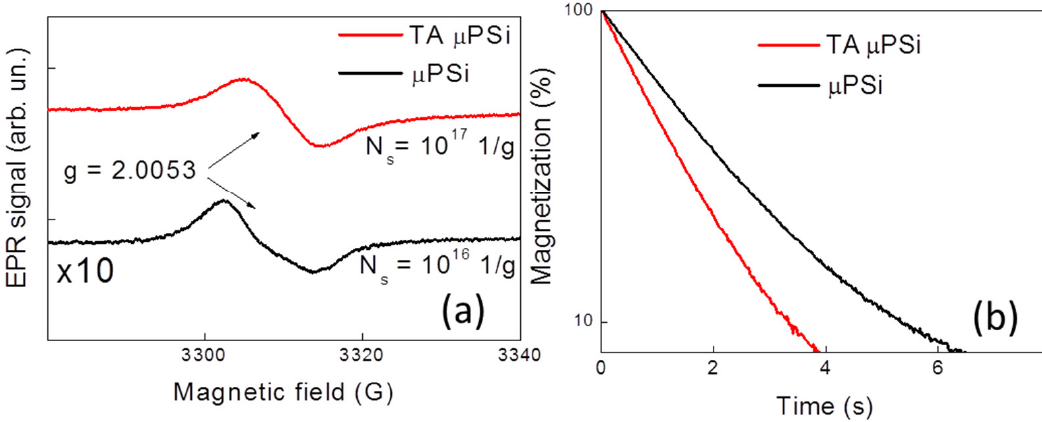
Figure 38. ( a ) EPR spectra of as-prepared (black line, the intensity is multiplied by 10) and thermally annealed in vacuum (red line) PSi NPs. ( b ) Transients of the transverse proton magnetization in aqueous suspensions of as-prepared (black line) and thermally annealed in vacuum (red line) µ PSi NPs. (Reprinted from Reference [96] by permission from John Wiley and Sons © 2018).